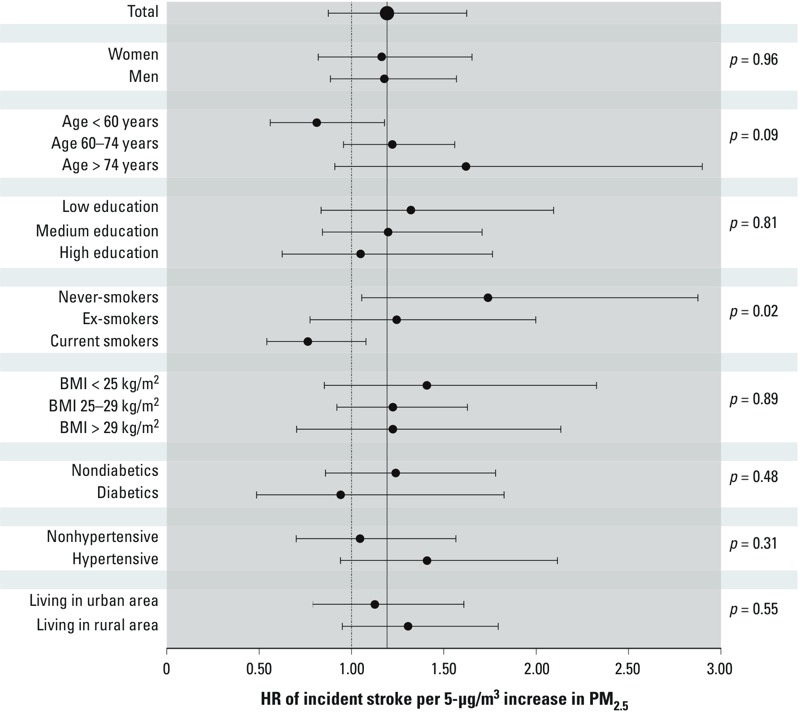
Association between PM2.5 exposure and stroke incidence in the 11 cohorts under study: results of the effect modification analysis. Values are HRs and 95% CIs per 5-μg/m3 increases in PM2.5. p-Values of effect modification (right) were calculated as heterogeneity tests among coefficients in different strata of the effect modifiers.